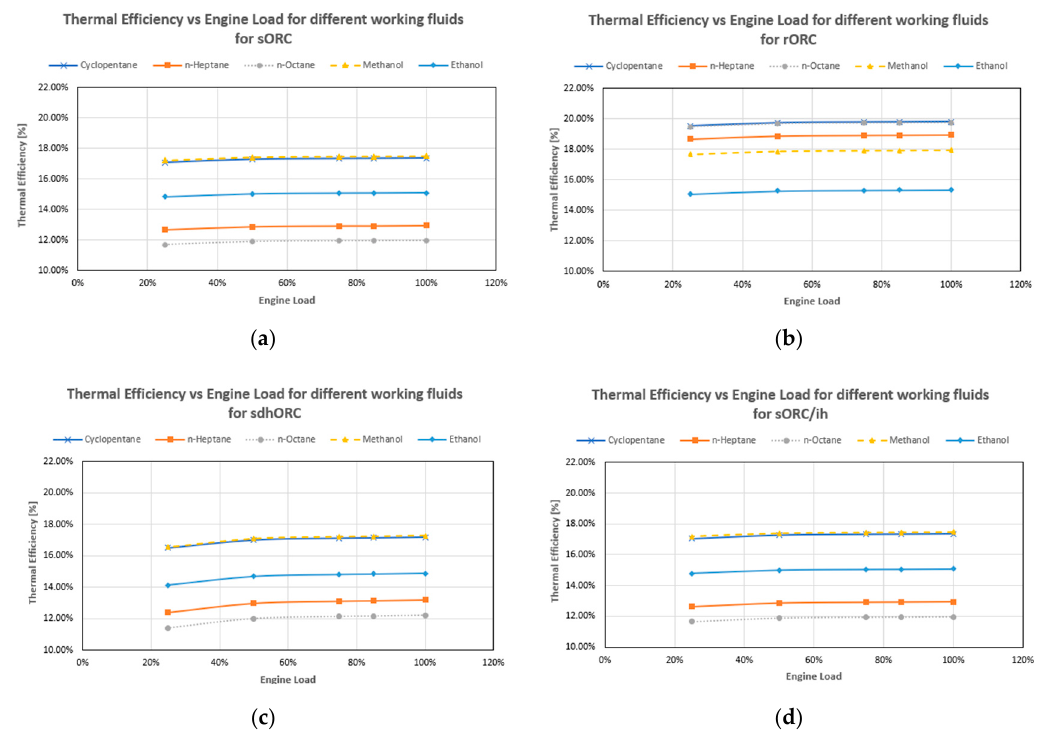
Figure 5. Thermal Efficiency vs Engine Load for different working fluids ( a ) sORC; ( b ) rORC; ( c ) 344 Figure5. ThermalE ffi ciencyvsEngineLoadfordi ff erentworkingfluids( a )sORC;( b )rORC;( c )sdhORC; sdhORC; ( d ) sORC/ih. 345 ( d ) sORC /